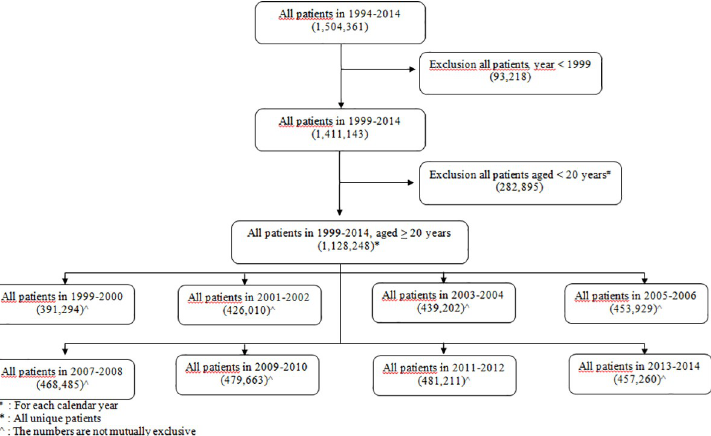
Fig 1. Flow chart of the study population comprising all adults aged 20 years and older present in the IADB.nl database from 1999 to 2014.